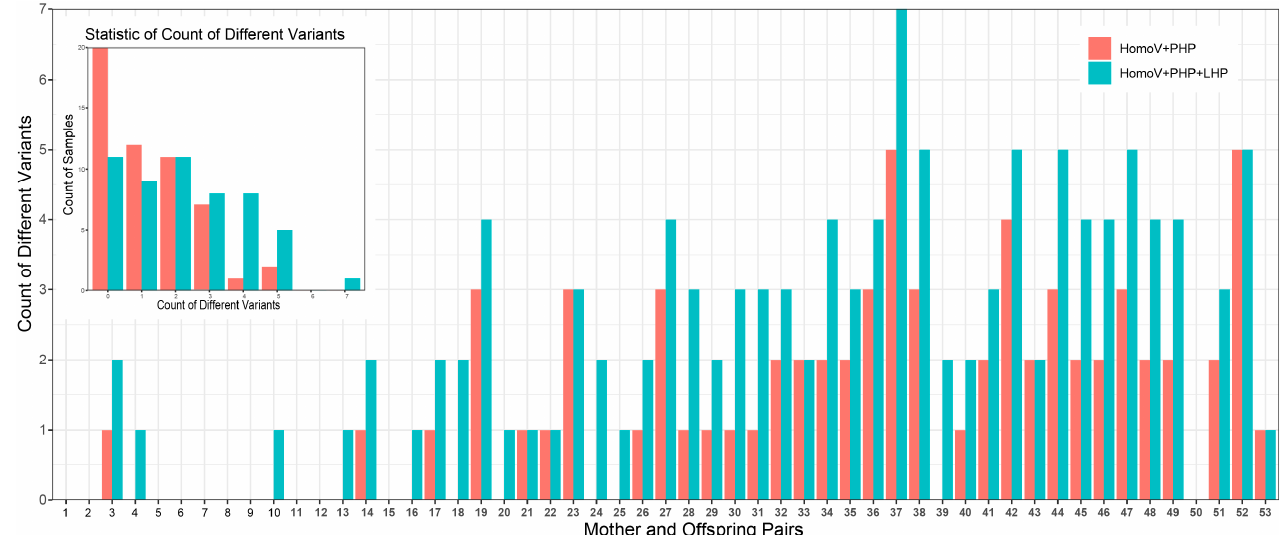
Figure 7. Counts of different variants in all compared mother–offspring pairs. Inherited PHPs were observed in Family1 (152Y), Family8 (3386Y), P08-P15 (9083Y), and P12-P18 (14215Y); conversely, de novo and disappearing PHPs were the majority (Table 3). The pairwise MAF differences between the mother and offspring were 10.19% and 12.54% in 3386Y and 9083Y, while the values were 1.31% in 152Y and 0.51% in 14215Y (Table